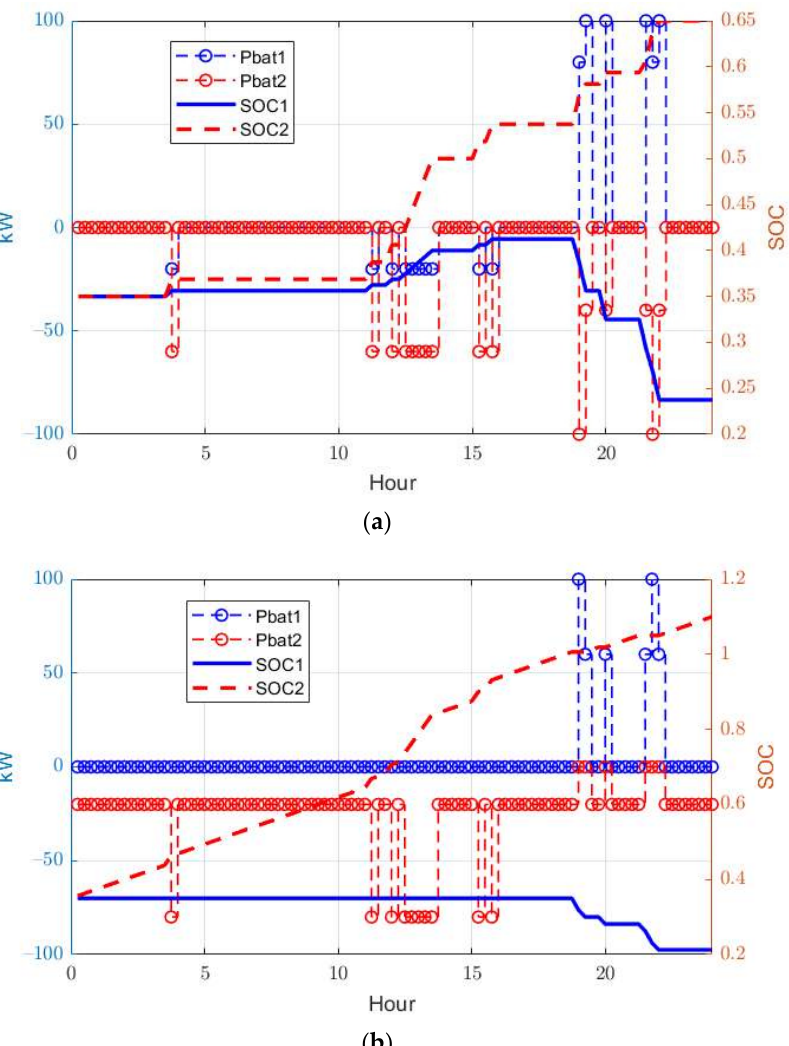
Figure 6. BESSs operation results under the maximum training episode of 3000: ( a ) Power profile and the state of charge (SOC) of the active exploration (AE) method; ( b ) power profile and the SOC of the Q ‐ learning (QL) method.